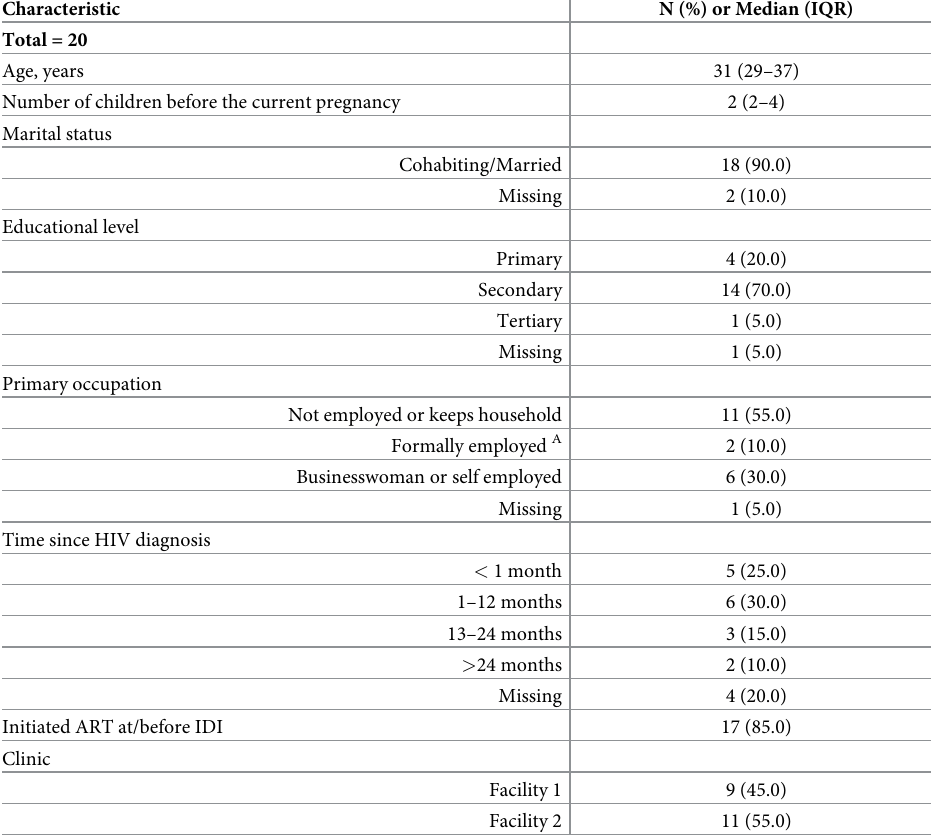
Table 1. Characteristics of pregnant and postnatal HIV-infected women participating in in-depth interviews (IDIs), Lusaka, Zambia,